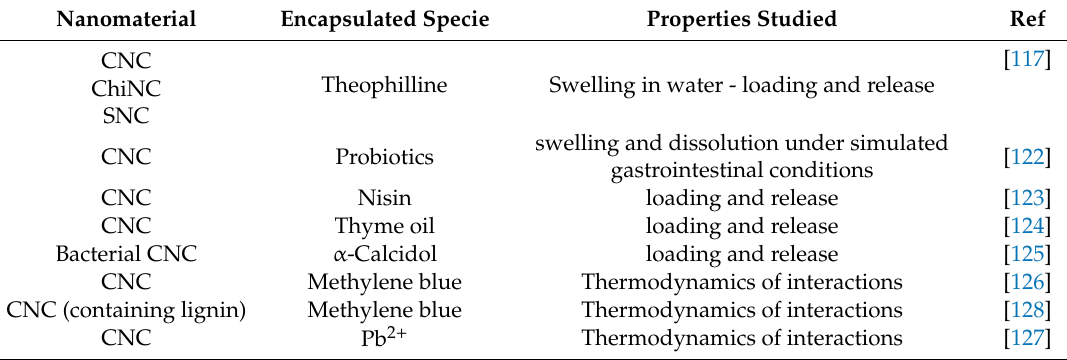
Table 1. Reported alginate / nanocrystals microcapsules for encapsulation of active